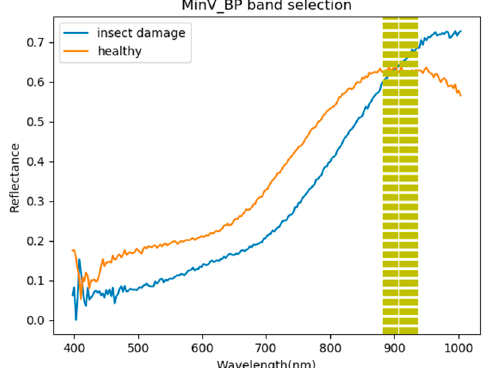
Figure 10. Visualization of the CEM_BDM band selection results. The first five bands are 933, 900, 869, 930, and 875 nm.